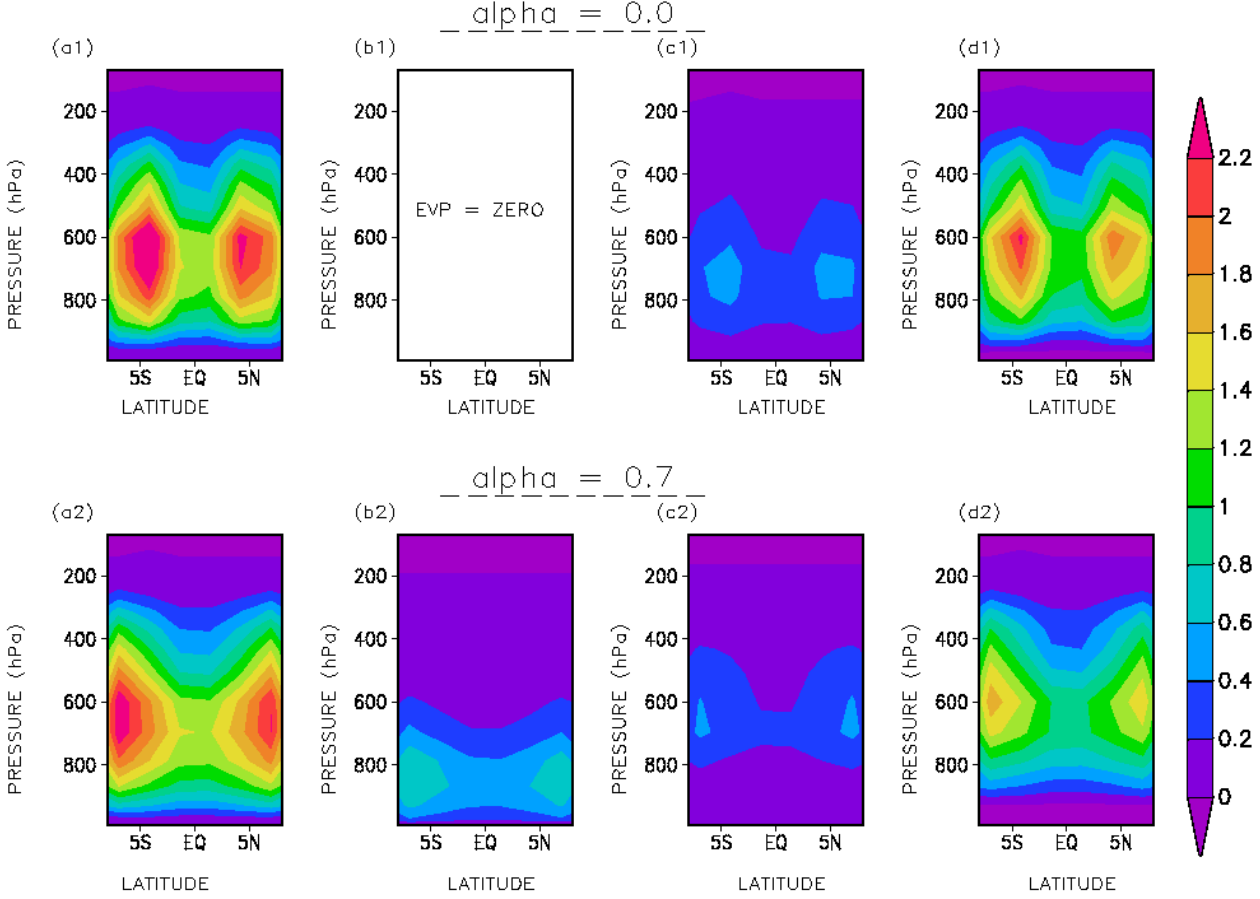
Fig. 4. Zonally averaged time mean quantities. Upper panel for α =0 and lower panel for α =0.7. (a1, a2) deep convective precipitation production rate (mm/day), (b1, b2) evaporation of the deep convective precipitation within the downdraft (mm/day), (c1, c2) grid scale evaporation of the deep convective precipitation (mm/day), (d1, d2) net deep convective precipitation production rate